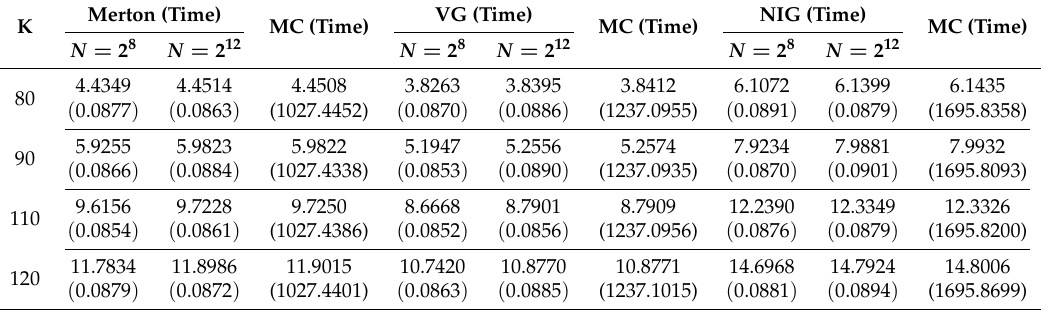
Table 4. Approximation results for GMDB, where X is Merton’s jump diffusion model (MJD), the Variance Gamma model (VG), or the normal inverse Gaussian model (NIG), b ( s ) = ( K − s ) + .